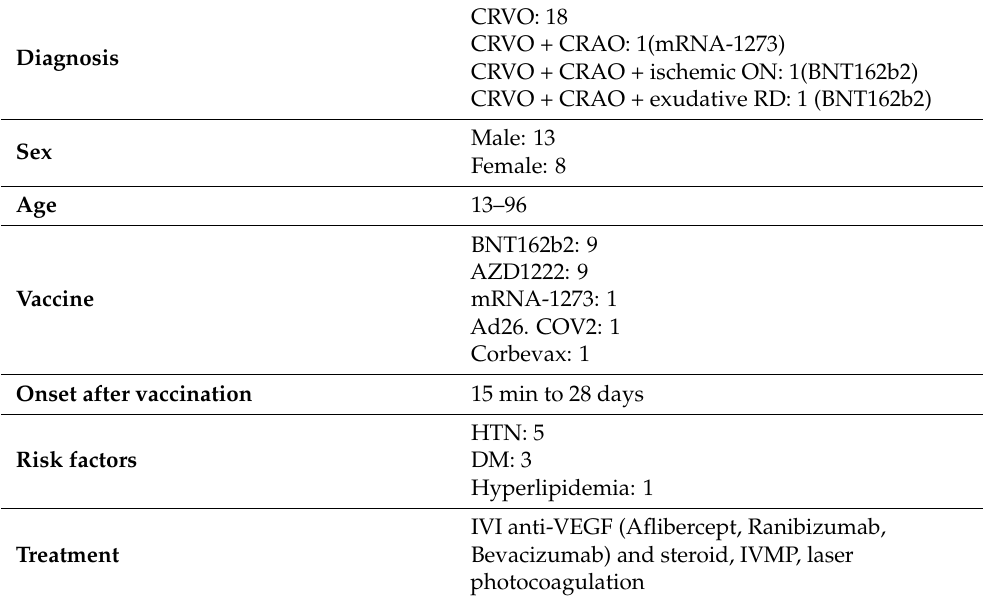
Table 3. Twenty-one cases of published central retinal vein occlusion (CRVO) after COVID-19 vaccination.